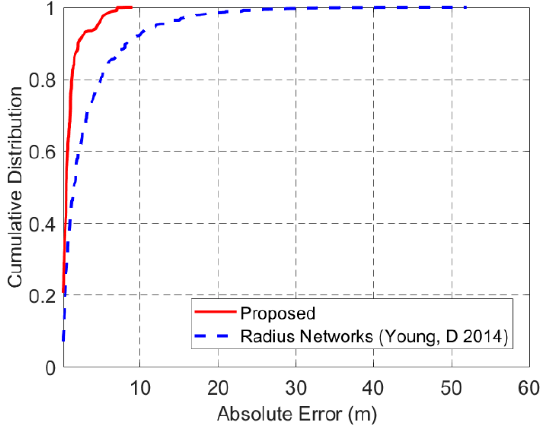
Figure 5. Cumulative error percentages in different cases [39]. Table 1. The comparison of static ranging errors. Stat.